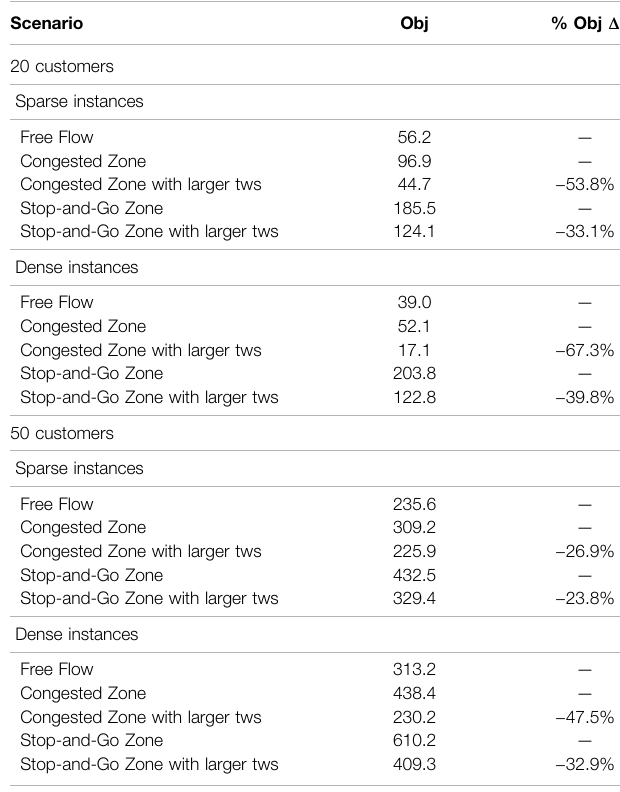
TABLE 3 | Objective function comparisons between 1-hour time windows and extended inner zone time